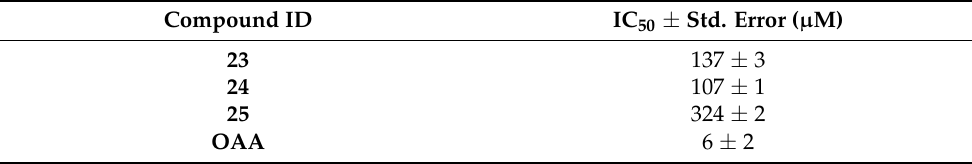
Figure 10. Examples of oxalamic acid diamides ( 23–25 ). Table 7. Pyridin-2-yl ( 23 ), naphthyl-2-yl ( 24 ) and pyrrolidine-1-yl ( 25 ) oxalamic acid amides. Data fit with GRAPHPAD PRISM 5. Standard error of the fit given in µM. IC50 diagrams, including the fit and standard deviations of the individual experiments ( n = 3), are depicted in the Supplementary Materials.